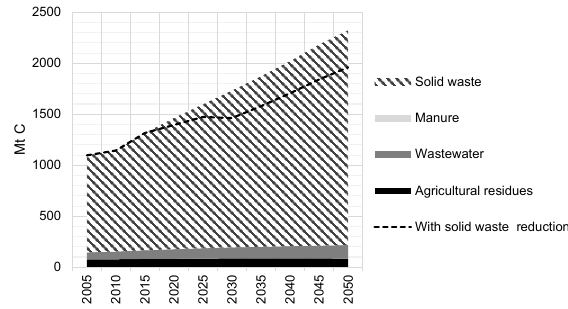
Figure 2. Projected global carbon